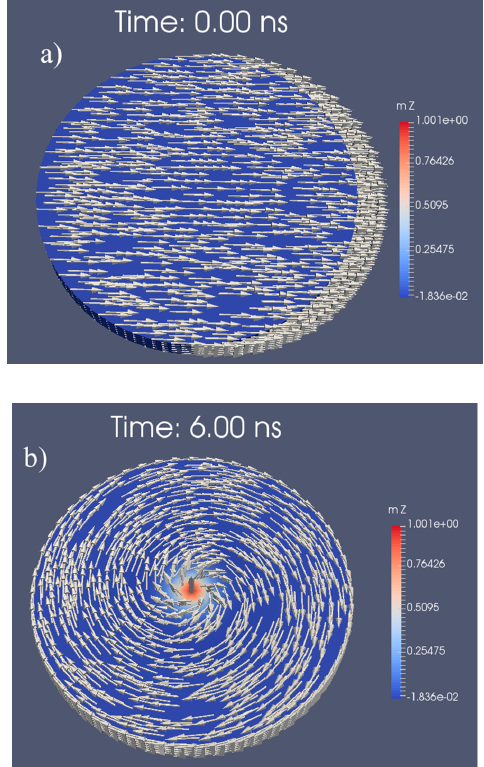
Figure 3. Vortex formation of a circular CoFe disk (d L = 100 nm, t L = 10 nm) starting ( a ) from the saturated state in the x-direction and ( b ) after a simulation time of 6 ns (b).